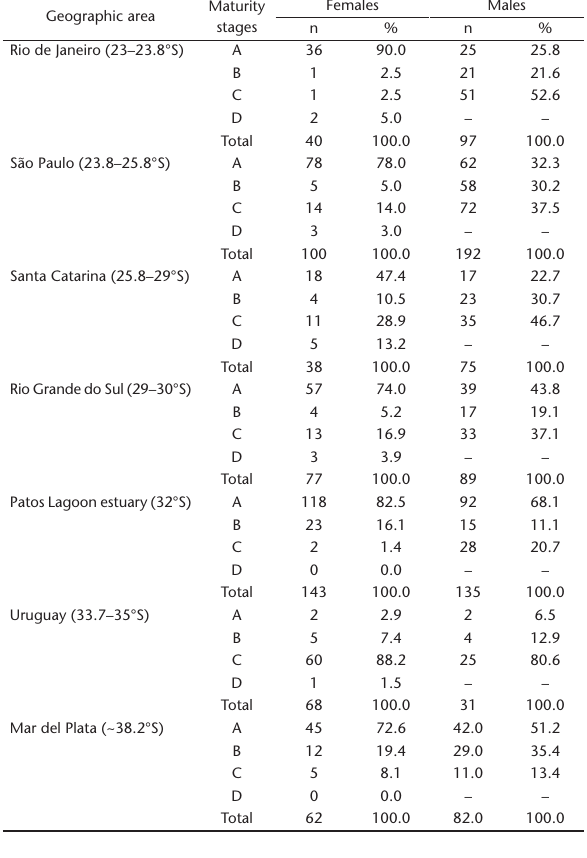
males) were in an advanced stage of maturity (i.e. stages B, C and D). Nearly 44.1% of the females were mature, whereas 14% were maturing. Only 13.3% of the females were found spent.